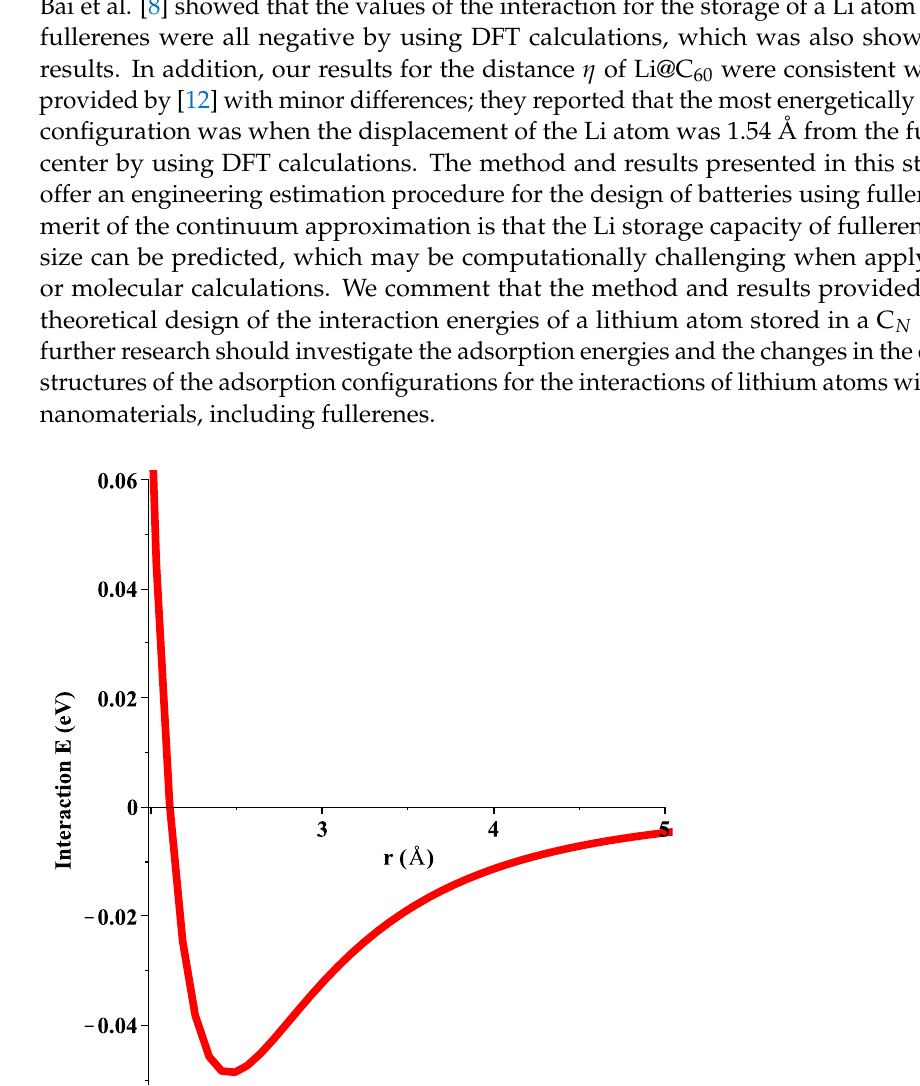
Figure 5. Total interaction between a Li atom and a fullerene as a function of the fullerene’s radius r